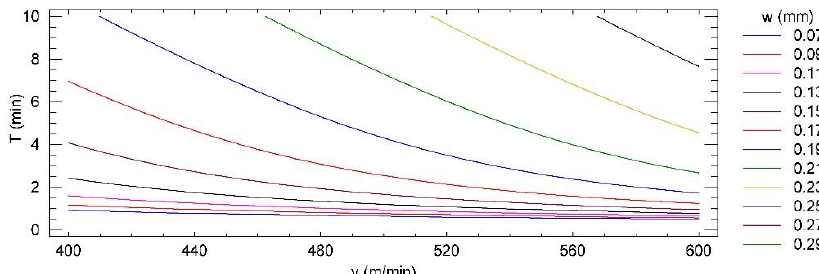
Figure 8. Contour plot for the relation between the input factors (machining time—cutting speed) and flank wear of GC4225 insert.